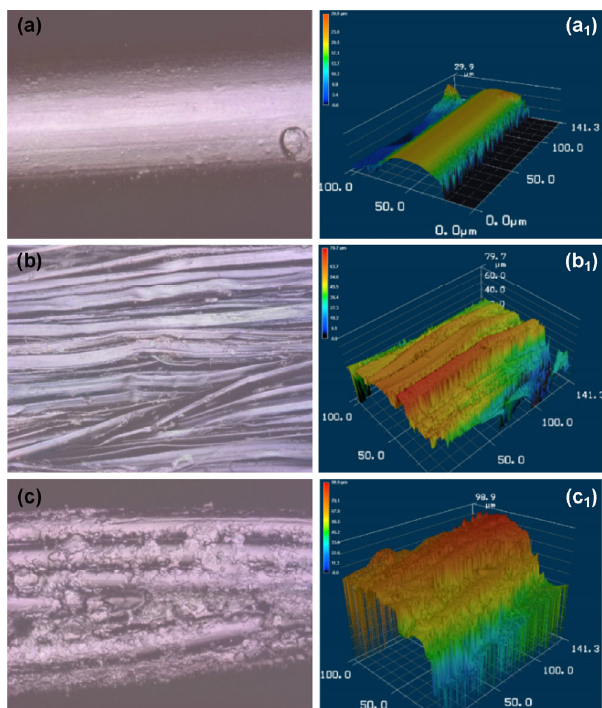
Fig. 5 Laser confocal images of the surgical suture: (a, a 1 ) Nylon (magnification 100×; pixel represents 0.0675 mm × 0.0675 mm); (b, b 1 ) silk (magnification 50×; pixel represents 0.135 mm × 0.135 mm), (c, c 1 ) vicryl (magnification 100×; pixel represents 0.0675 mm × 0.0675 mm).